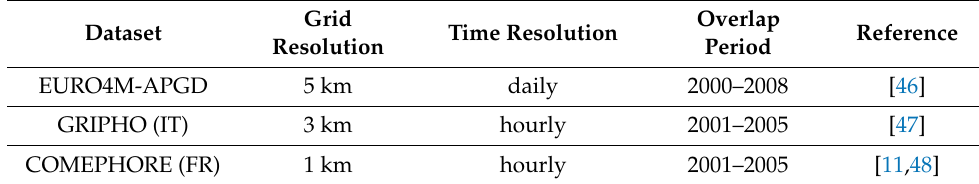
Table 1. List of used observational data sets.